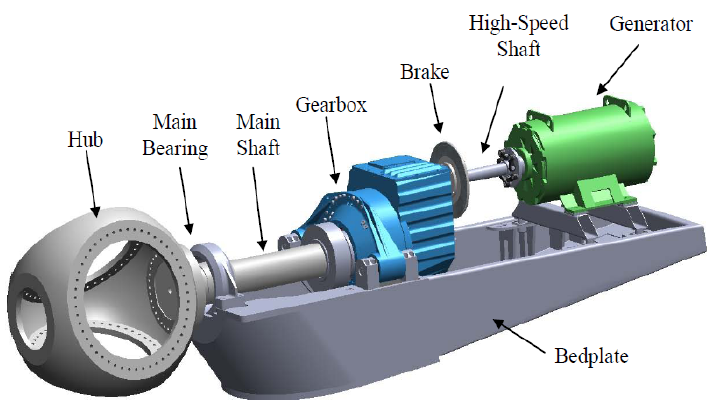
Figure 1. Drive train configuration of the wind turbine [16].